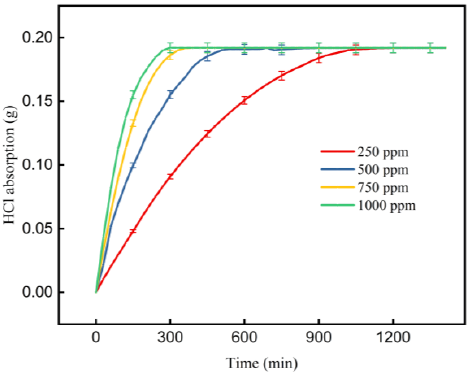
Figure 6. HCl removal capacity with different HCl concentrations under CO 2 concentration of